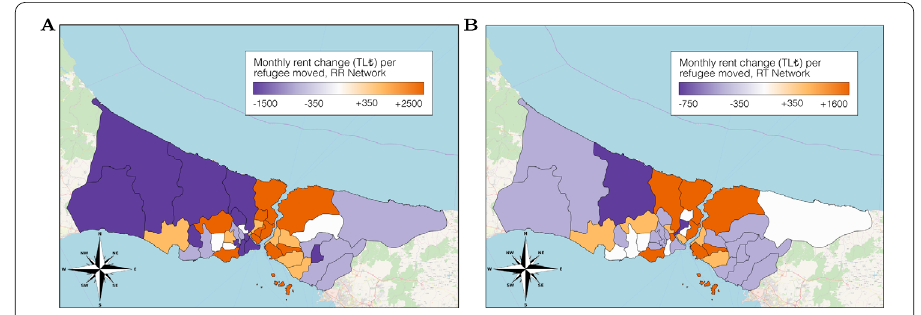
Figure 9 Maps, for each corresponding network, of the average monthly rent change per refugee arriving in each district. These maps complement the distributions of Fig.